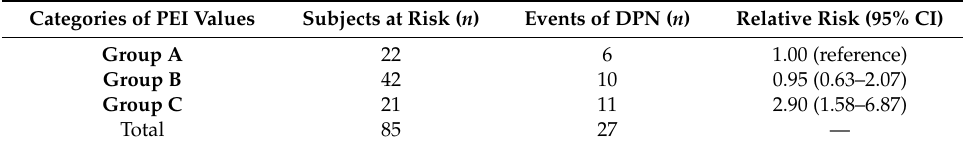
Table 4. Progression to DPN within six years of follow-up and relative risks as a function of three categories of